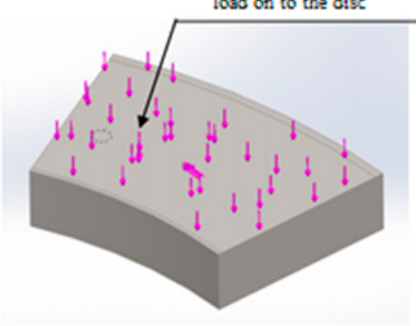
Figure 12. Acting load on the mirror surface of the disc.